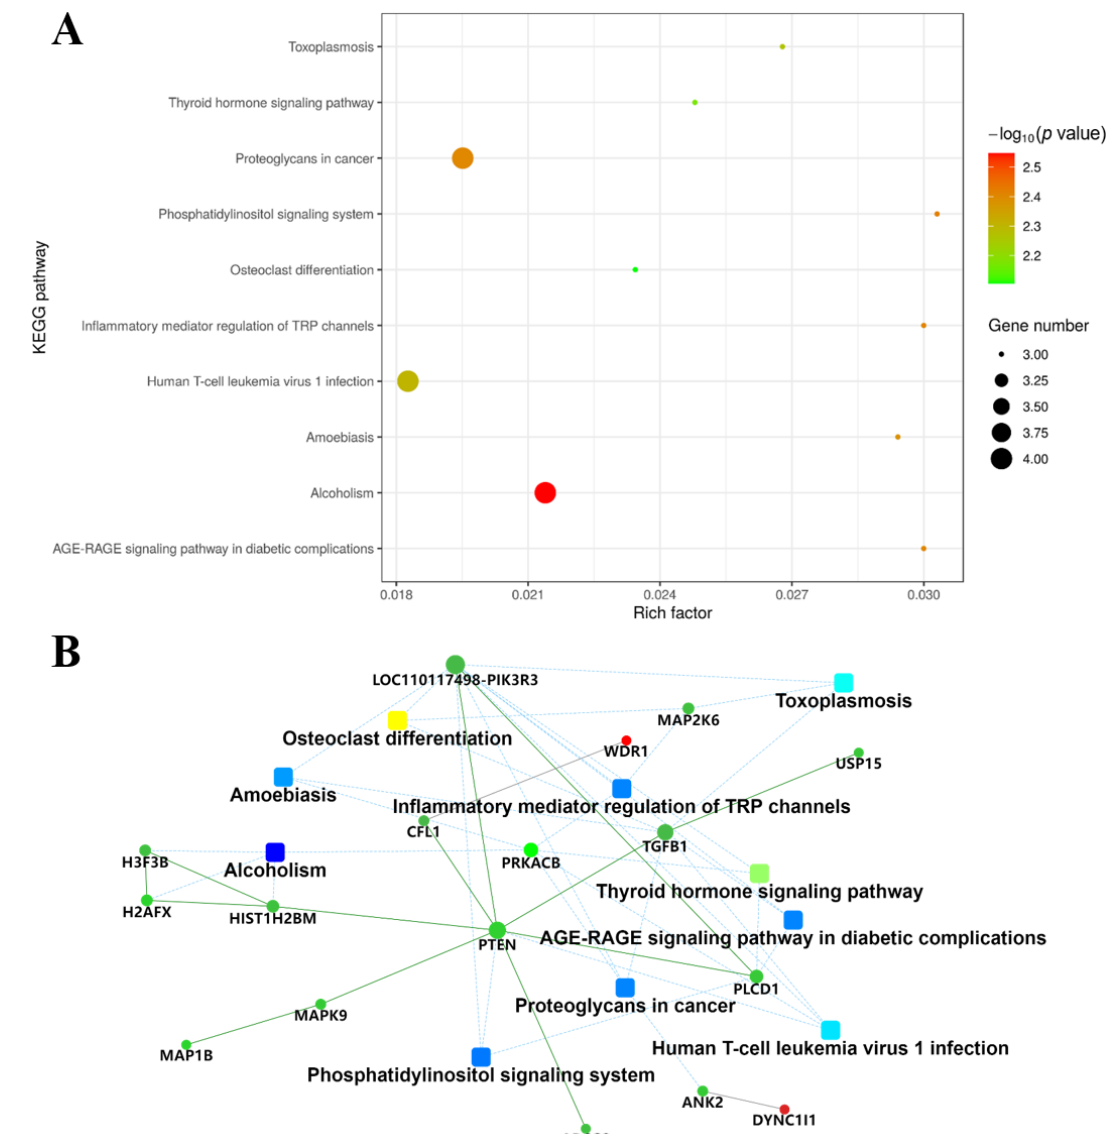
Figure 4. KEGG pathway and PPI analysis. ( A ) Pathway bubble chart of the top 10 results of differential protein KEGG enrichment. ( B ) PPI analysis was performed based on factors such as fold change of differentially expressed proteins, enrichment of the KEGG pathway, and biological processes.